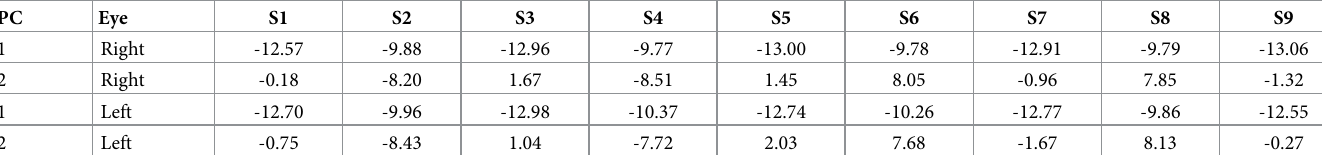
Table 5. Principal component analysis coefficients of the first two principal components for right and left eyes.